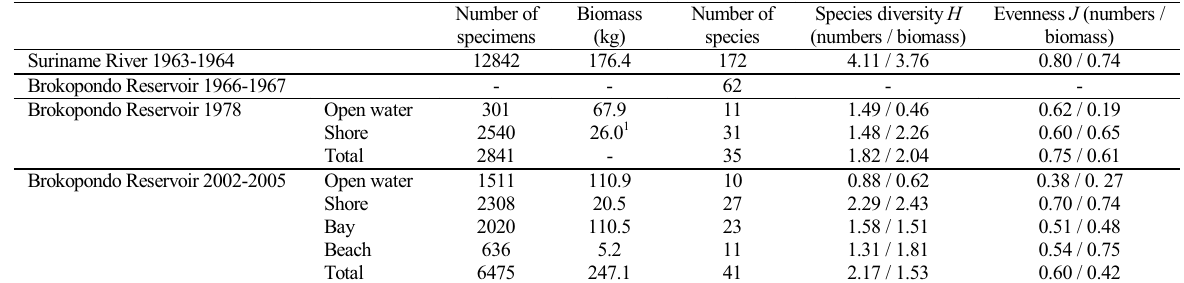
Table 2. Fish community parameters for Suriname River (pre-impoundment 1963-1964) and four different habitats in Brokopondo Reservoir in 1966-1967, 1978 and 2002-2005. Biomass of shore fish community in 1978is given in kg per ha 1 .